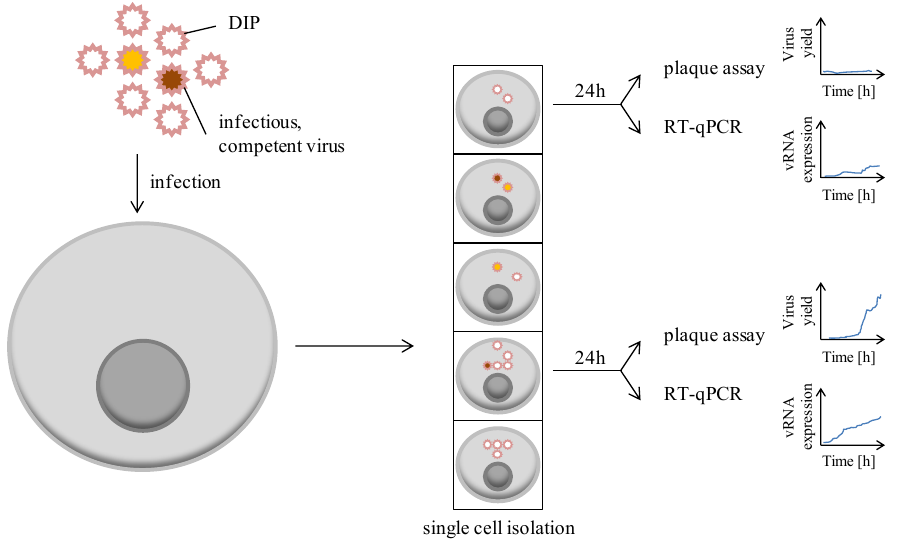
Figure 2. Single cells display cell-to-cell variability in infectious viral progeny. Cells are infected at a determined multiplicity of infection, usually represented by a virus aggregate containing infectious (colored) and defective particles (empty, defective interfering particles, DIP). The genomic sequence of infectious, competent viruses may vary among viral particles, represented here by a yellow and a red particle. After infection, cells are separated and grown for 24 h. Cells are then collected for assessing specific gene expression (usually viral RNA) by RT-qPCR, while supernatants are collected to perform plaque assay for infectious titer determination.